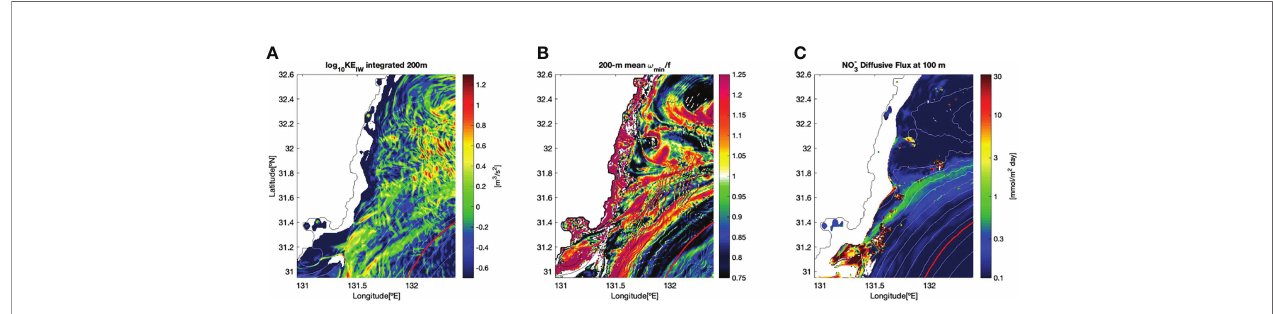
FIGURE 8 | Plane views on December 20 th at hour 18:00 of (A) internal wave kinetic energy integrated over 200 m depth (m 3 s -2 ), (B) the minimum internal wave frequency divided by Coriolis parameter w min/f averaged within upper 200 m, and (C) nitrate diffusive fl ux (mmol m -2 day -1 ) interpolated at 100 m depth. Red line represents the Kuroshio axis at SSH =